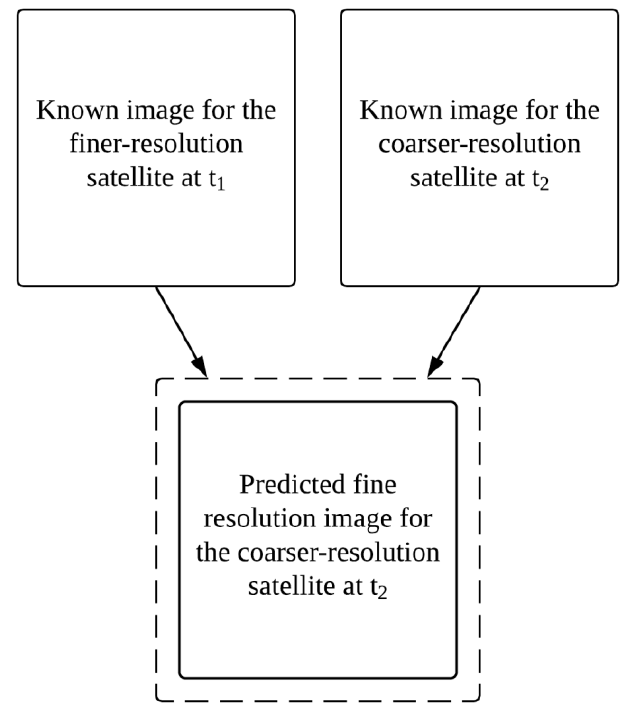
Figure 2. Architecture of HNN-SPOT, the newly proposed spatio-temporal data fusion model. Suppose t 1 represents the known date and t 2 represents the prediction date.